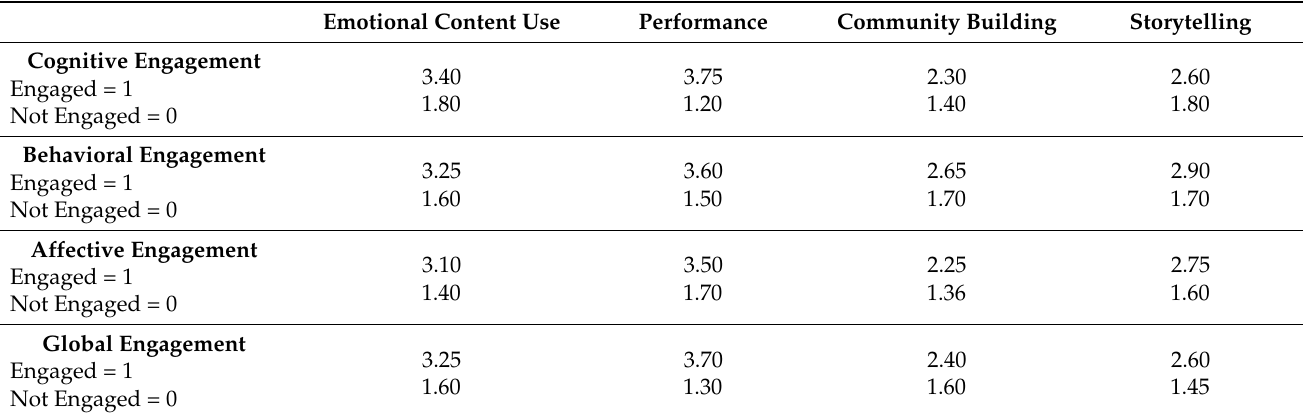
Table 6. Simple comparison of means of the four faculty engagement practices by students’ engage- ment measures. Emotional Content Use